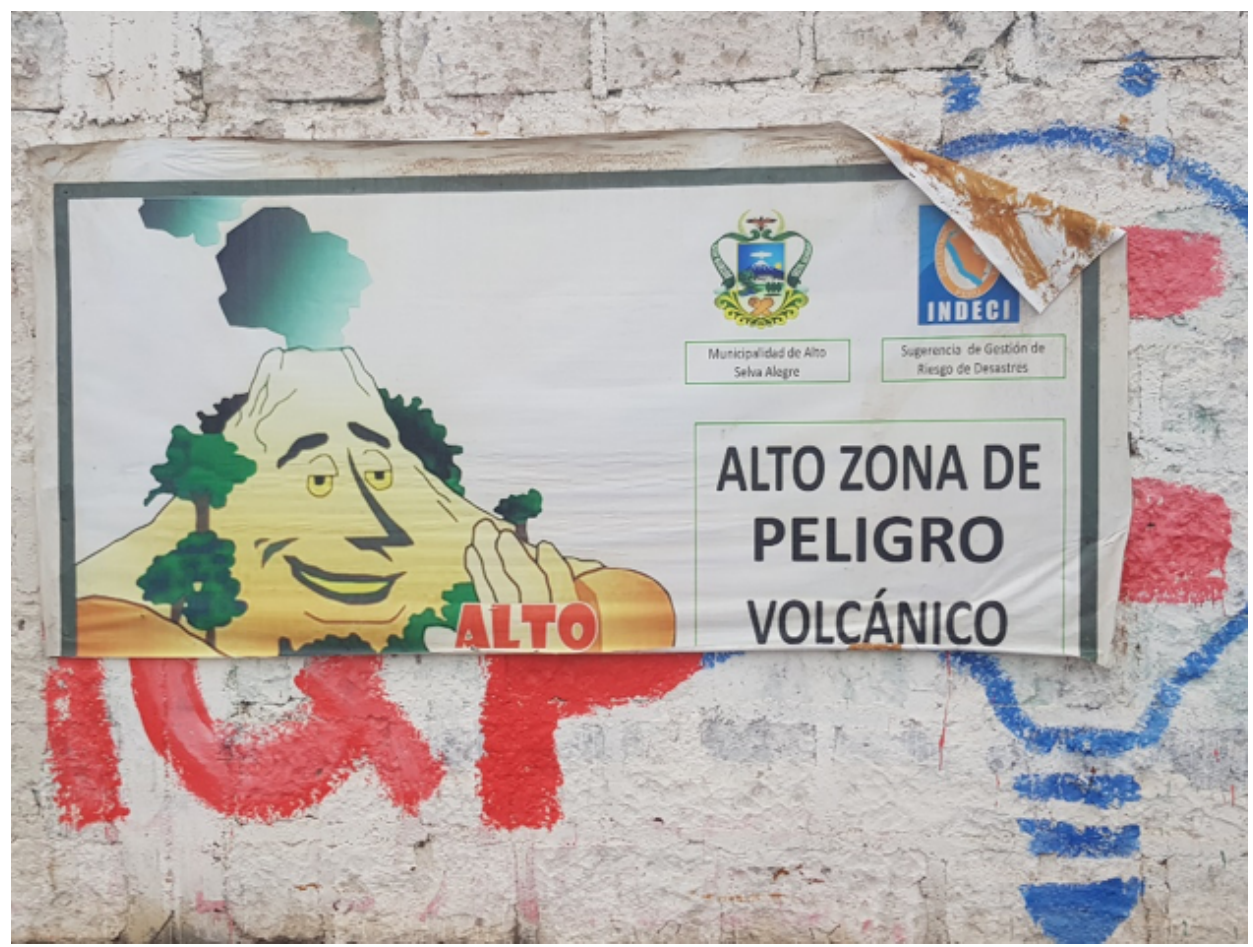
Figure 2: “Mr. Misti” taken down on the heights of Alto Selva Alegre, January 2020, photo credit: S.